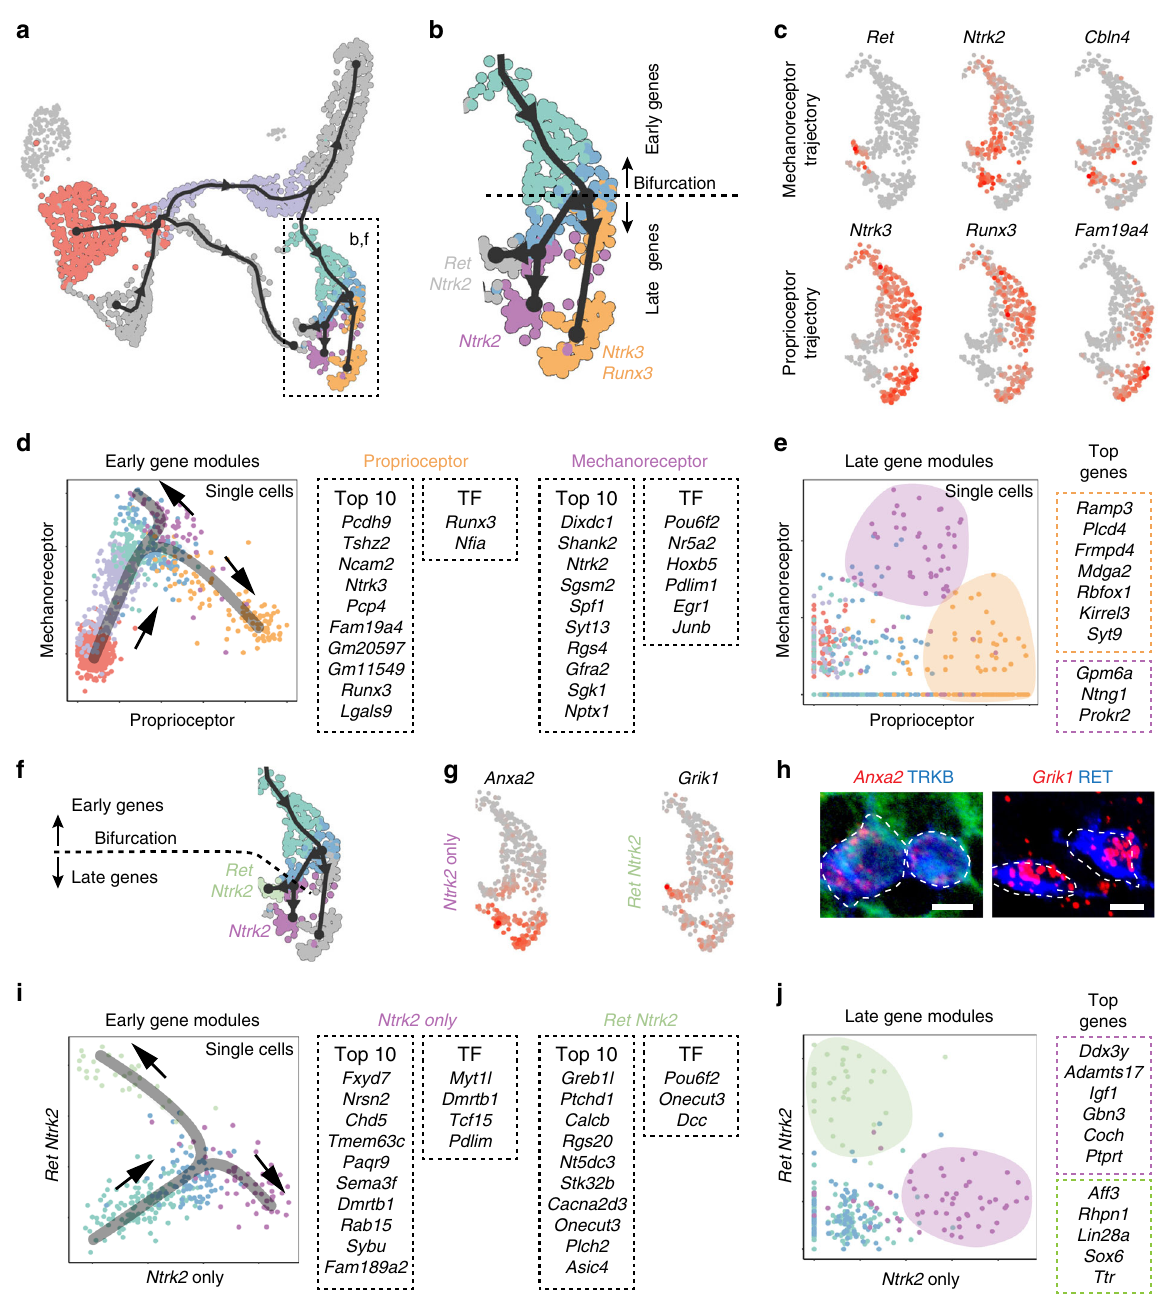
Fig. 3 Expression of gene modules de fi ning fate choice and commitment along the differentiation trajectories. a Overview of the analyzed bifurcations on UMAP embedding. b Analysis of the bifurcation representing fate choice between proprioceptor and mechanoreceptor lineages (branches 8 and 9 of Fig. 1c). c UMAP plots showing expression of markers for mechanoreceptor and proprioceptor lineages and validated in vivo (see Supplementary Fig. 3). d , e Scatter plots show average expression of mechanoreceptor and proprioceptor modules in each cell along the mechanoreceptor and proprioceptor lineages. Early competing modules ( d ) show gradual co-activation, followed by selective upregulation of one fate-speci fi c module and downregulation of the alternative fate-speci fi c module. Late modules ( e ) show almost mutually exclusive expression within the proprioceptors and mechanoreceptors after bifurcation re fl ecting commitment to either fates. Color codes as in ( a ). Top ten highest differentially expressed genes are shown, as well as transcription factors (TF). f Analysis of the bifurcation representing mechanoreceptor fate choice between Ntrk2 and Ret / Ntrk2 lineages (branches 10 and 11 of Fig. 1c). g , h In vivo validation of the branches, with expression of Anxa2 for Ntrk2 fate and Grik1 for Ret / Ntrk2 fate ( n = 3 animals). Scale bars, 10 µ m. i , j Scatter plots show average expression of Ntrk2 and Ret / Ntrk2 modules in each cell among the two mechanoreceptor sub-lineages. Early competing modules ( i ) show gradual co-activation, followed by selective upregulation of one fate-speci fi c module and downregulation of the alternative fate-speci fi c module. Late modules ( j ) show almost mutually exclusive expression within the two mechanoreceptors lineage after bifurcation. Color codes as in ( a ). Top ten highest differentially expressed genes are shown, as well as transcription factors